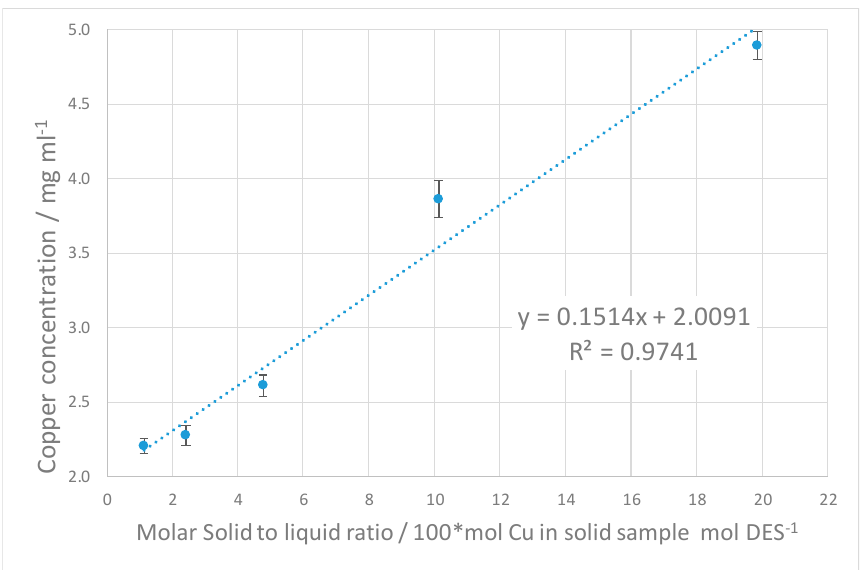
Figure 4. Correlation between the ratio of the initial molar copper content in chalcopyrite and the deep eutectic solvent molar content with the copper solution concentration after 240 min of dissolution at temperature of 50 °C.